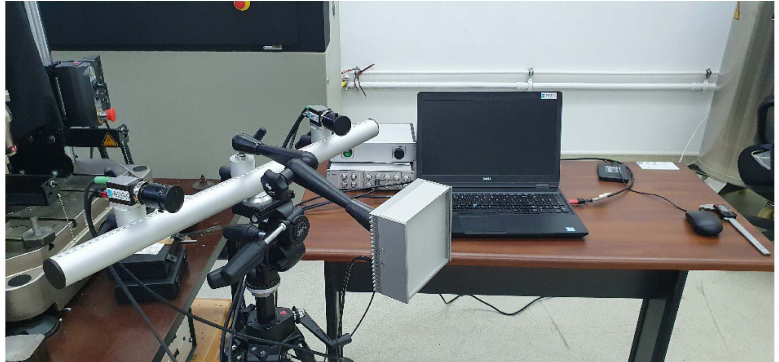
Figure 2. The Q400 Digital Image Correlation